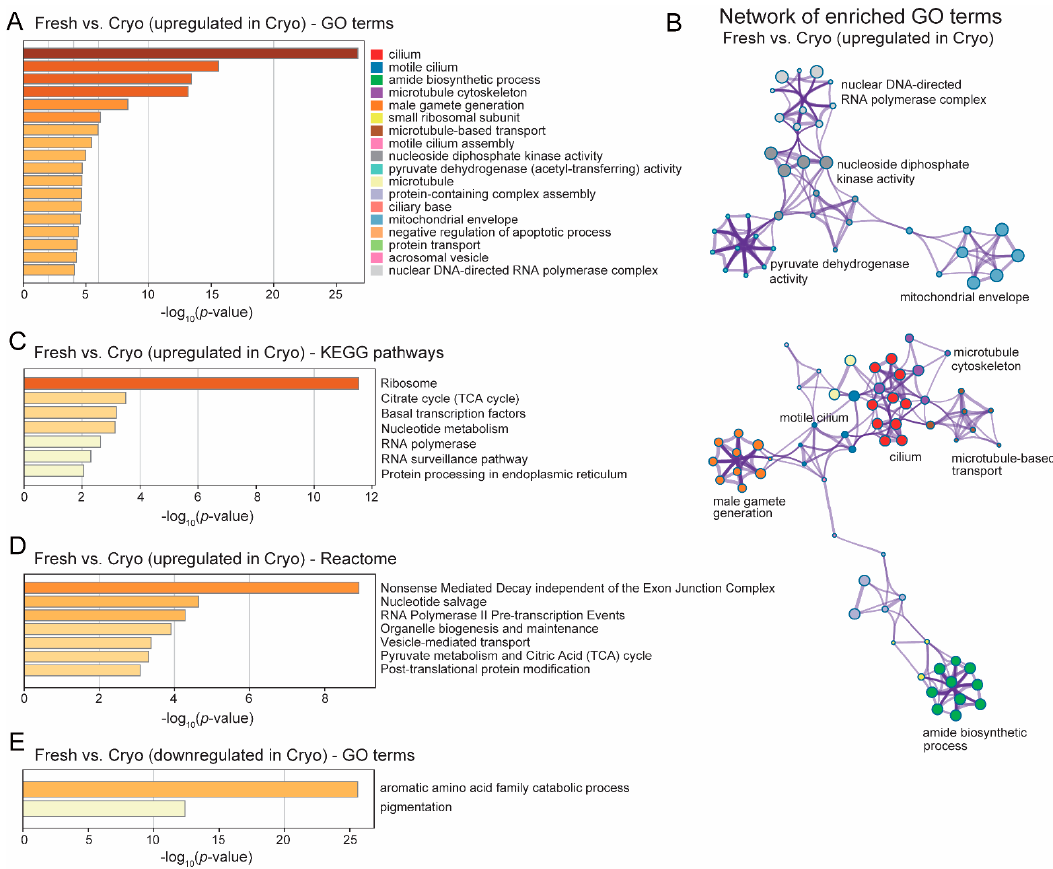
Figure 4. GO terms and pathway enrichment analyses of differentially expressed genes (DEGs) in cry- opreserved sperm in blue catfish, Ictalurus furcatus . ( A ) Enriched functional GO terms for upregulated genes in cryopreserved sperm compared to fresh-frozen sperm with a cut-off of − log 10 ( p -value) >